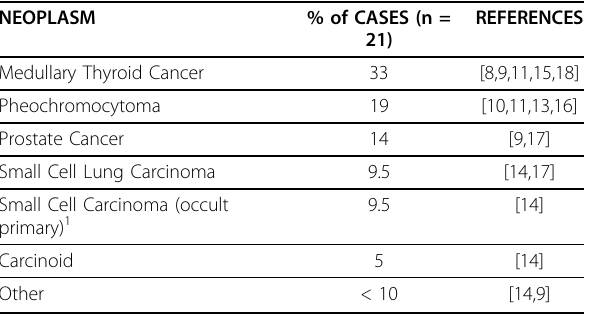
Table 2 CRH Positive and ACTH negative Tumors causing Cushing ’ s Syndrome